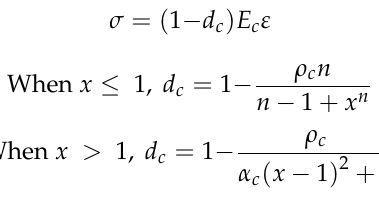
Figure 3. Laboratory test photos: ( a ) mold-making, ( b ) bolt installation, ( c ) concrete pouring and curing, ( d ) concrete strength test, ( e ) calibration of load sensor, ( f ) test load.